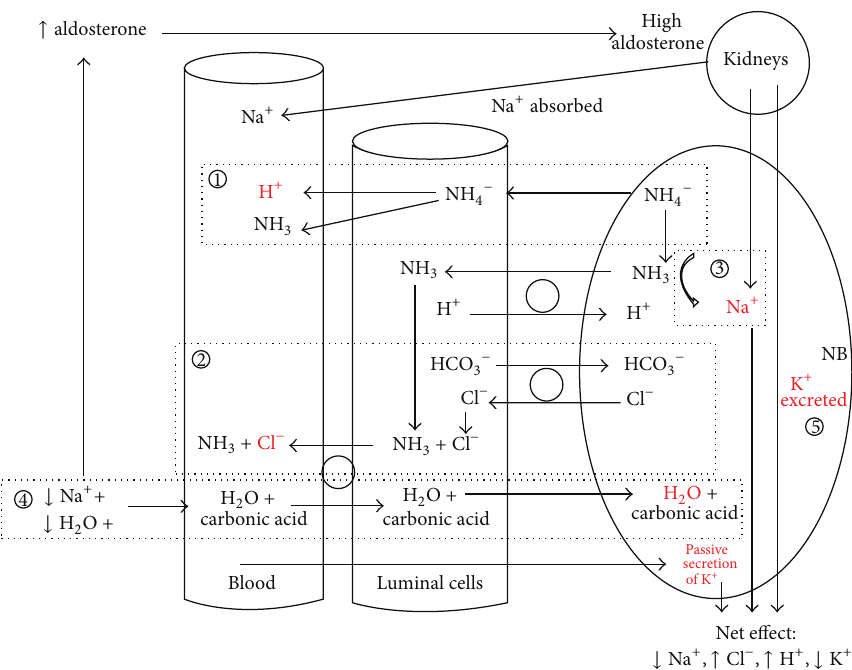
Figure 1: Electrolyte abnormalities in patients with ileal and/or colonic OBS. (1) NH 4− absorption from urine which dissociates to H + and NH 3 resulting in metabolic acidosis. (2) Cl − is exchanged with HCO 3− and transported into blood. (3) Na + is displaced by NH 4− and not absorbed by bowel resulting in a net loss. (4) There is a net loss of H 2 O resulting in dehydration and loss of Na + due to NB secretion of Na + into urine. (5) Elevated aldosterone levels due to Na + loss precipitates K + loss from renal tubules. Na + : sodium; K + : potassium; NH 4− : ammonium; NH 3 : ammonia; HCO 3− : bicarbonate; H + : hydrogen; H 2 O: water; Cl − : chloride; NB: